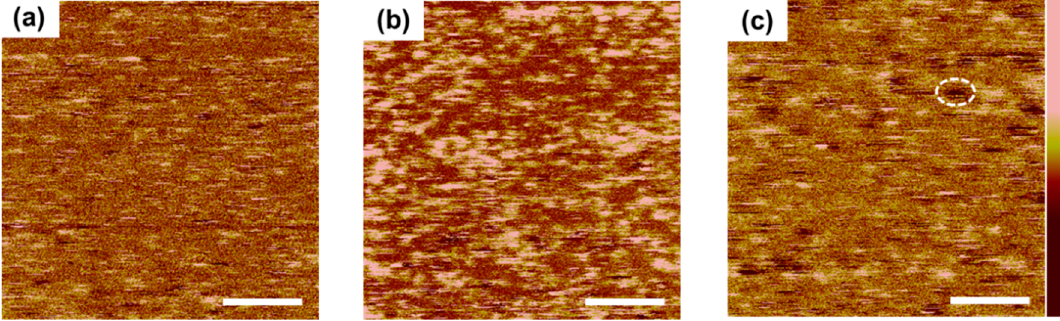
Figure 6. Tunneling mode atomic force microscope (TUNA) images of ( a ) 0.5 HQ; ( b ) 1.0 HQ; and ( c ) 1.5 HQ mixture ratios with 10 mM of BQ in MeOH. (scan scale = 200 nm × 200 nm; scale bar - 50 nm).